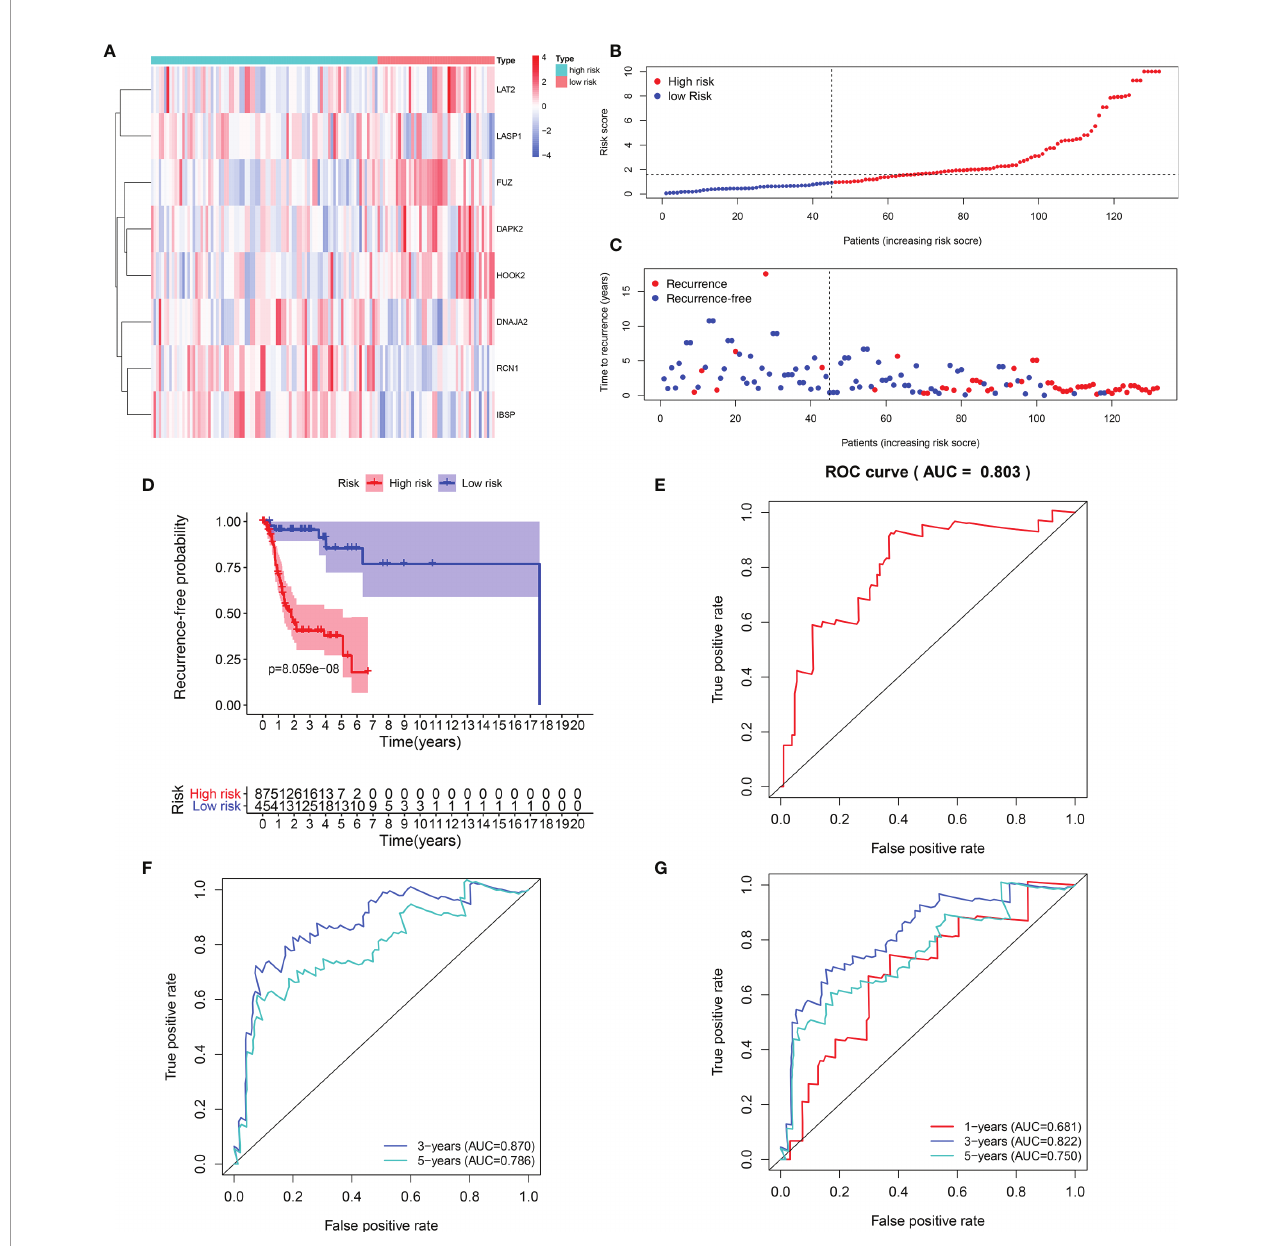
FIGURE 2 | Evaluation of the predictive ef fi cacy of the signature for laryngeal cancer recurrence in the training set. (A) Heat maps depicting the expression patterns of these eight genes including RCN1, LAT2, DAPK2, DNAJA2, FUZ, LASP1, IBSP and HOOK2 between high- and low- risk score group. Red: up-regulation and blue: down-regulation. (B) Ranking of risk scores among all laryngeal cancer patients. (C) Distribution of recurrence time among all laryngeal cancer patients. Red dots express recurrence laryngeal cancer samples and blue dots represent non-recurrence samples. The dotted line indicates the optimal cutoff value of risk score. The left side of the line represents low-risk patients, while the right side represents high-risk patients. (D) Recurrence-free survival between high- and low- risk score groups. (E) ROC curve for predicting the patients ’ 1-year recurrence. (F) ROC curves for predicting the patients ’ 3 and 5-year recurrence. (G) ROC curves for prediction of 1, 3- and 5-year OS